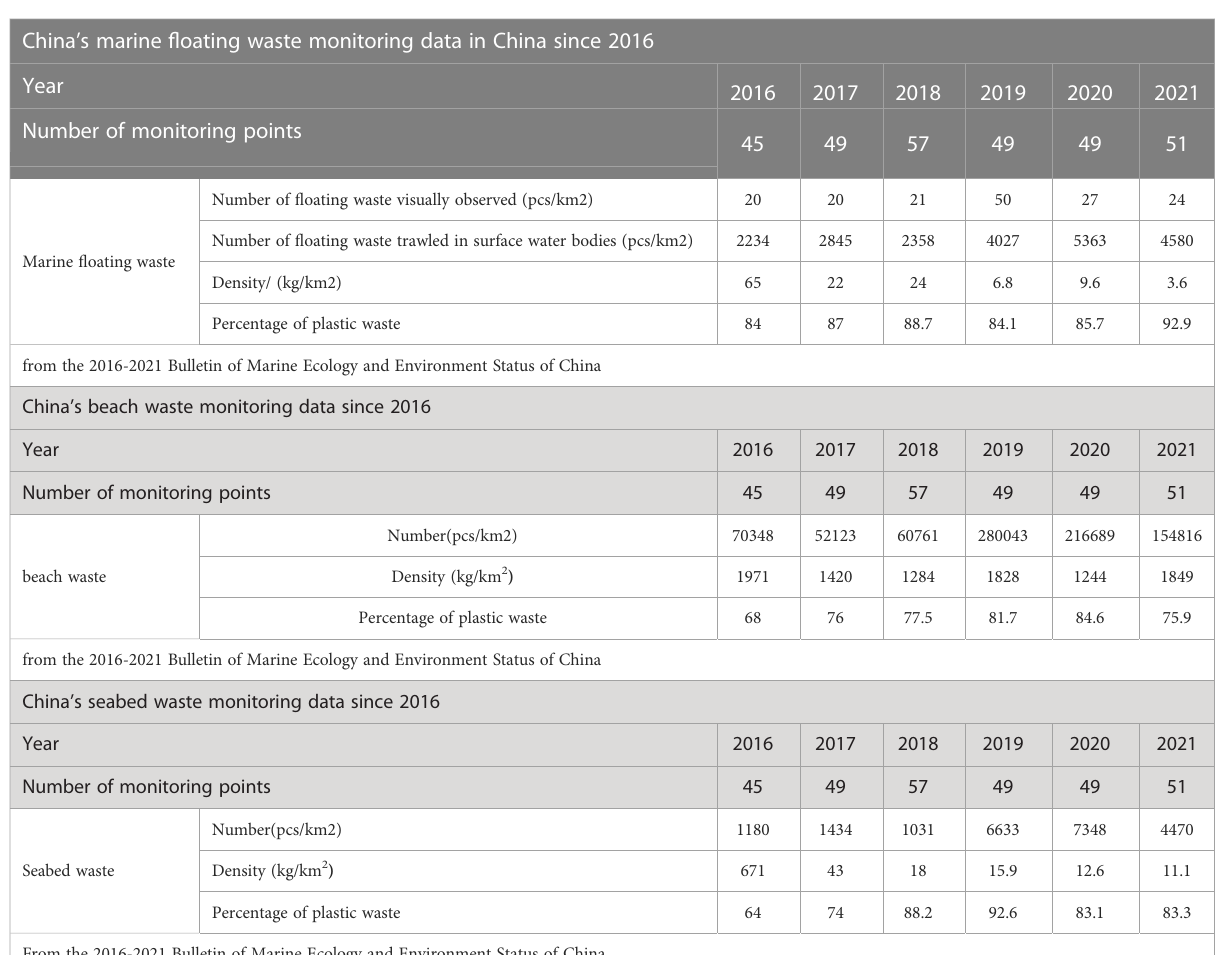
TABLE 1 China ’ s marine microplastic waste monitoring data since